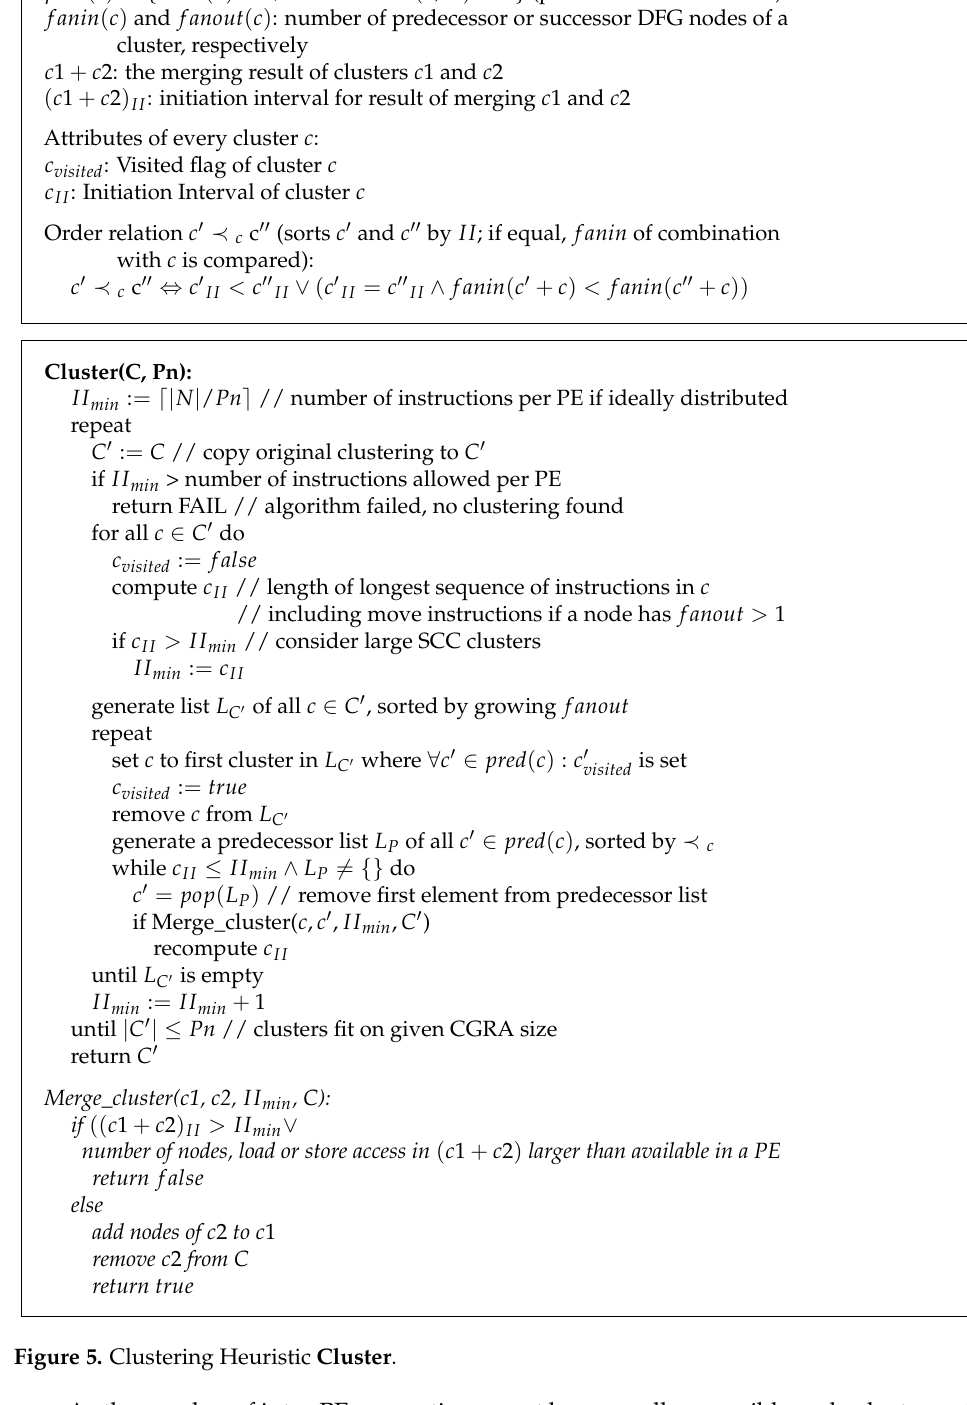
fanout values are preferred because they lead to a smaller fanout of the merged cluster if